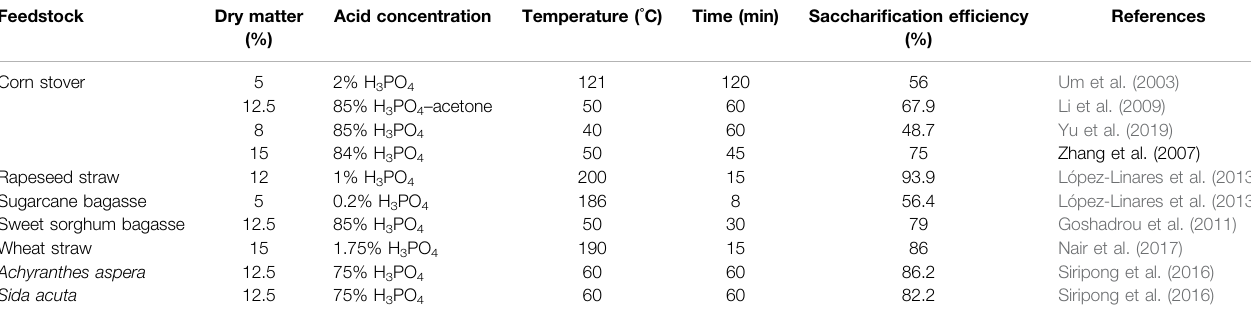
TABLE 2 | In fl uence of different concentrations of H 3 PO 4 on the treatment of different feedstocks.